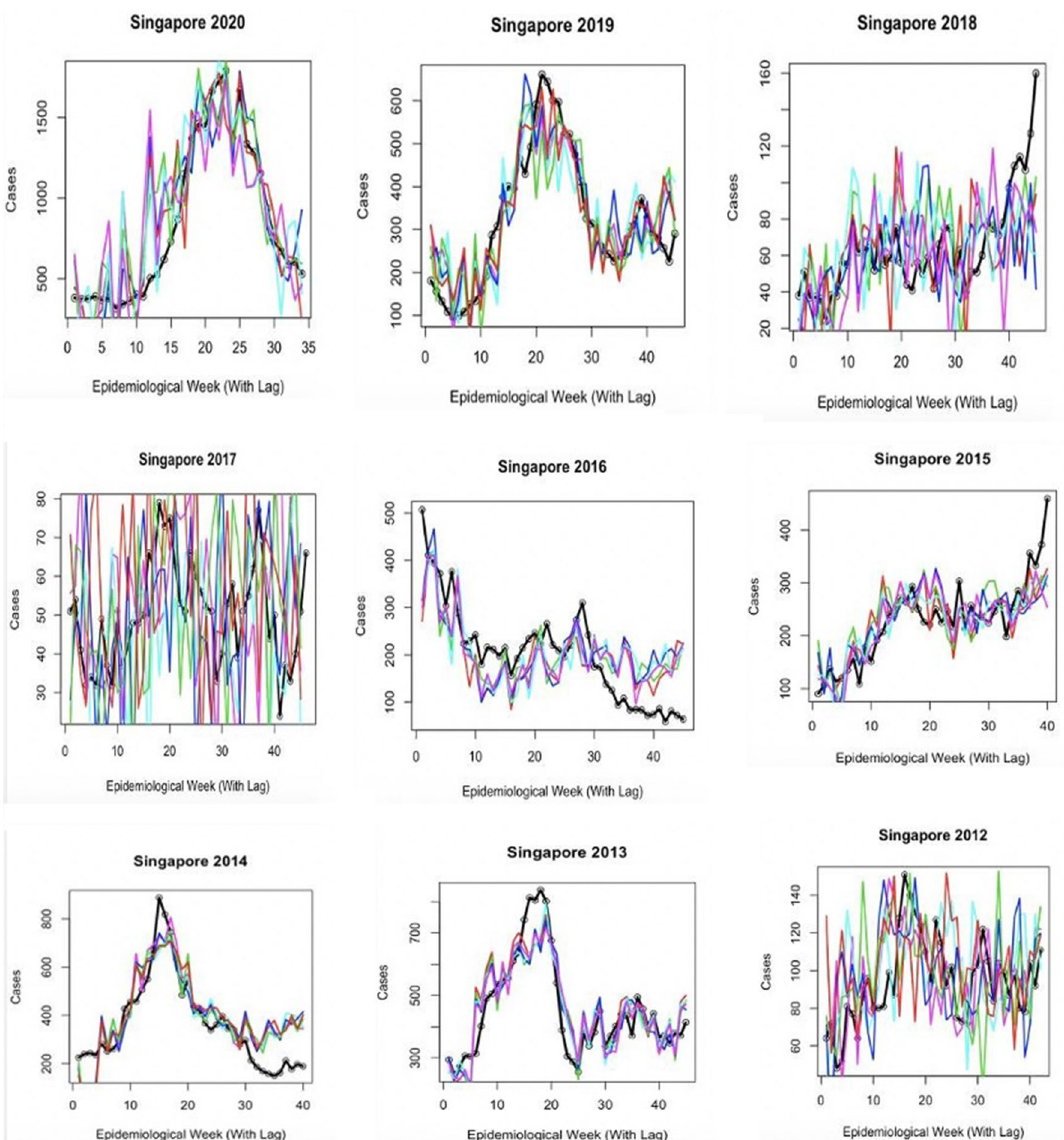
Figure 6. Graph showing the results of climate model testing (with lag) for Singapore model from 2012 to 2020. Colored lines represent five different forward simulation runs. Solid black line is the reported case count for each